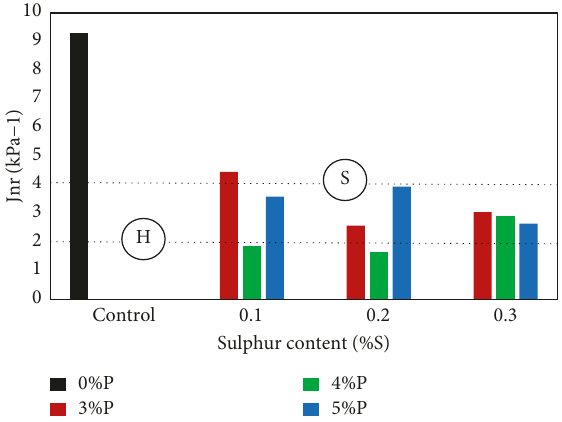
Figure 9: Nonrecoverable creep compliance (Jnr) values of base and modified bitumen at different sulfur and polymer contents tested at 64 °